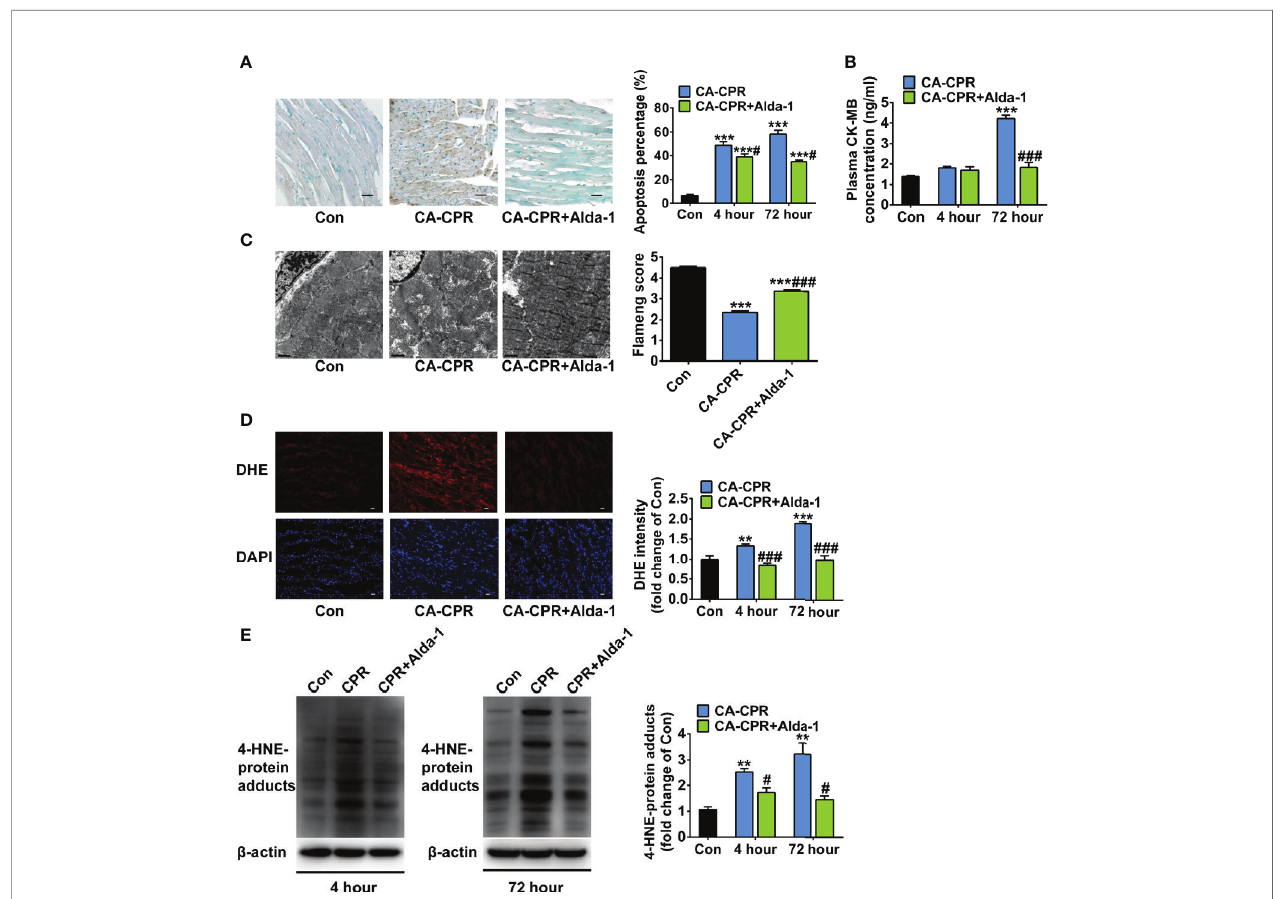
FIGURE 3 | The effect of ALDH2 activation by Alda-1 on post-cardiac arrest cardiomyocyte death, mitochondrial structural damage, and cardiac ROS levels. (A) Representative photographs of cardiomyocyte apoptosis by TUNEL staining at 4 h after ROSC and quanti fi cation at 4 h and 72 h after ROSC ( n = 3 – 4 animals per group). Scale bar = 100 m m. (B) The plasma levels of CK-MB at 4 h and 72 h after ROSC ( n = 3 – 4 animals per group). (C) Representative photographs and quanti fi cation of mitochondrial morphology by TEM examination at 1 h after ROSC ( n = 3 animals per group). Scale bar = 1 m m. (D) Representative photographs of dihydroethidium (DHE) staining at 4 h after ROSC and quanti fi cation at 4 h and 72 h after ROSC (n = 3 – 4 animals per group). Scale bar = 100 m m. (E) Representative immunoblots and quanti fi cation of 4-HNE-protein adducts at 4 h and 72 h after ROSC ( n = 3 – 4 animals per group). Group comparisons were performed by ANOVA with Tukey ’ s post hoc test. Data are presented as mean ± SEM. ** P < 0.01, *** P < 0.001 versus Con group; # P < 0.05, ### P < 0.001 versus CA-CPR